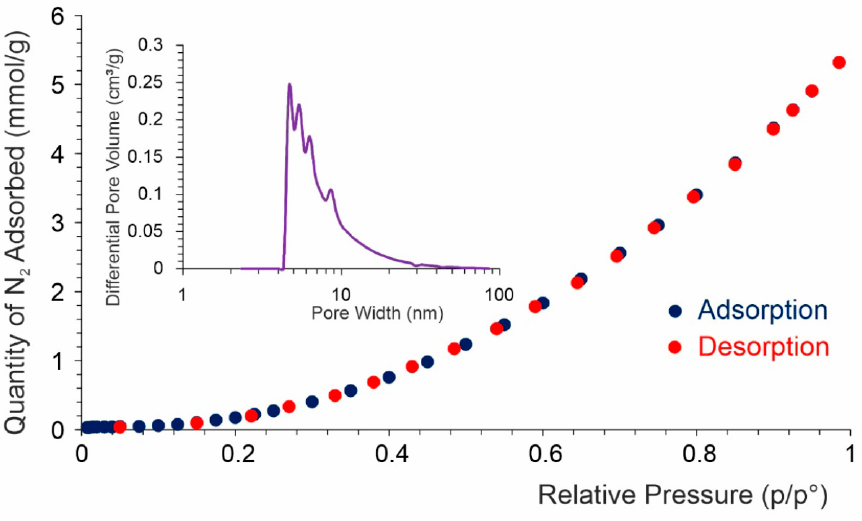
Figure 4. N 2 adsorption-desorption isotherm (inset: pore size distribution). Water contact angle measurements can only be performed on flat and stable surfaces.